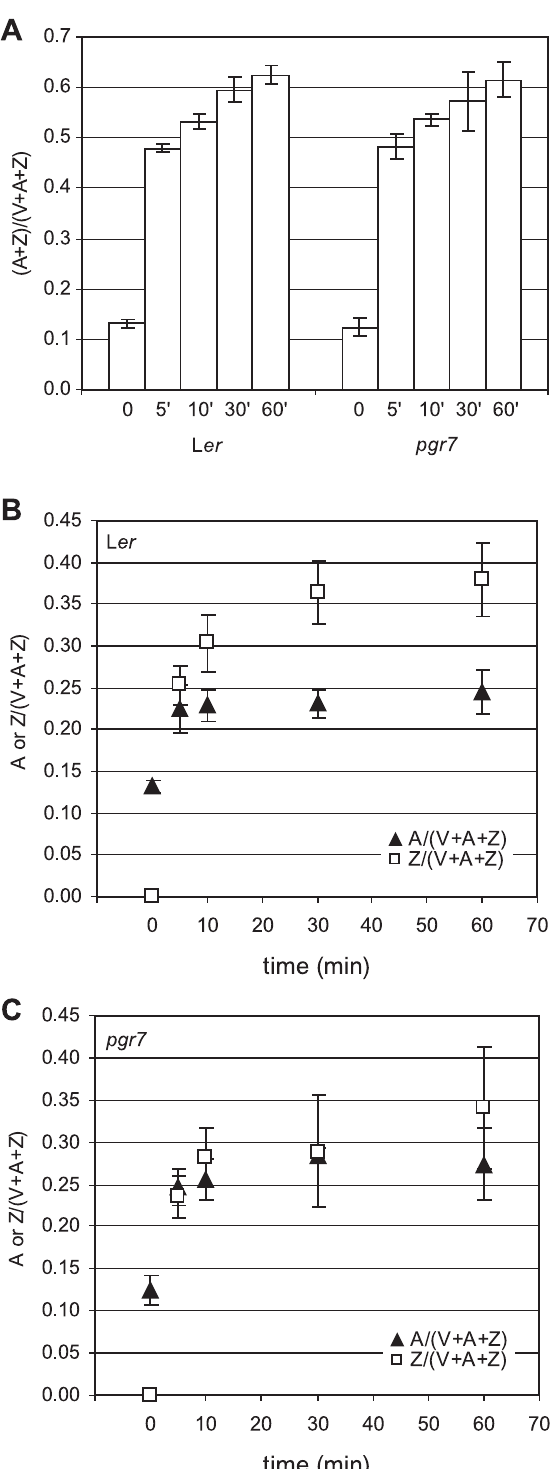
Figure 4. Characterization of the xanthophyll cycle in pgr7 . The composition of the xanthophyll cycle pigments (Violaxanthin: V; Antheraxanthin; A; Zeaxanthin: Z) was determined in low light (LL: 150 m mol photons m 2 2 s 2 1 ) (0) and after being treated in high light (HL: 1100 m mol photons m 2 2 s 2 1 ) for 5 min (5 9 ), 10 min (10 9 ), 30 min (30 9 ) and 60 min (60 9 ). Each data point represents the mean of three measurements with SD. A) De-epoxidation state [(A + Z)/(V + A + Z)] of pgr7 and L er . B) A (closed triangles) and Z (open squares) levels in L er . C) A (closed triangles) and Z (open squares) levels in pgr7 .